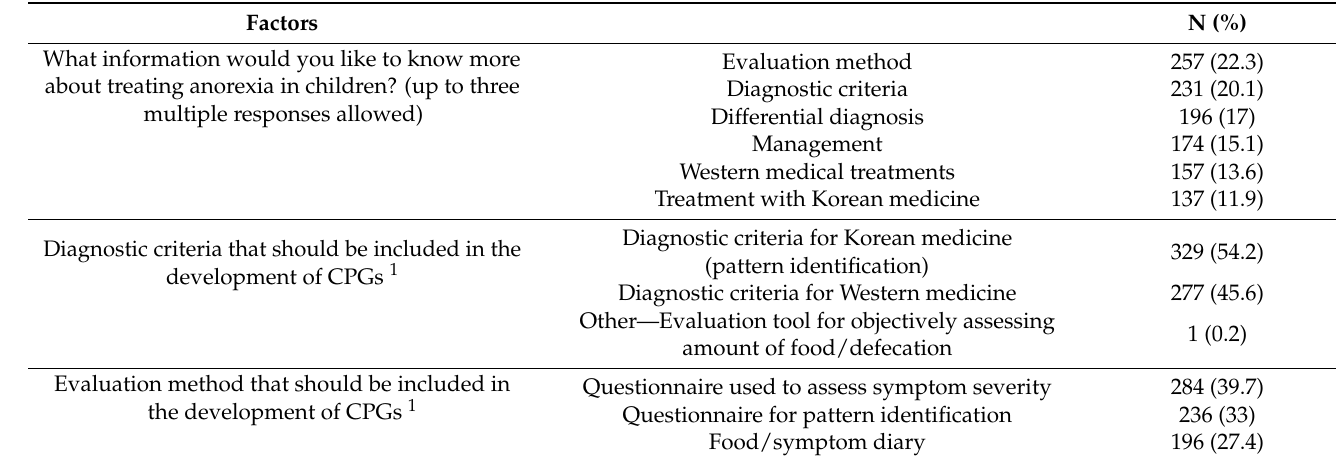
Table 7. Content to be included in the clinical practice guidelines for anorexia treatment in children (N =